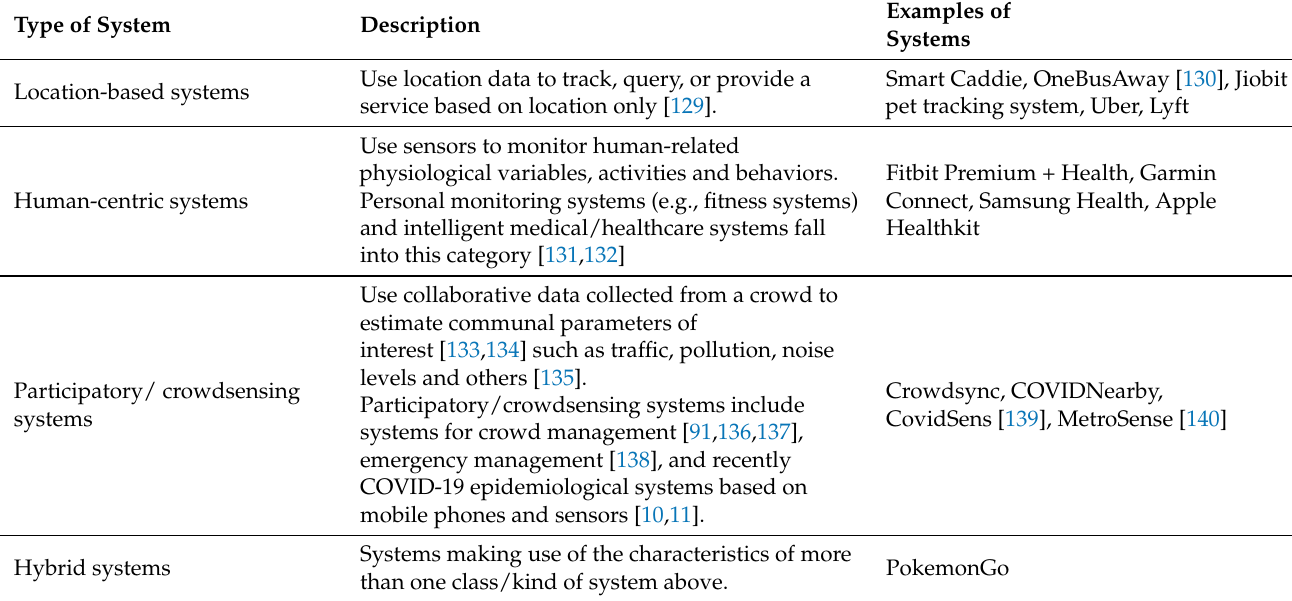
Table 4. Types of wearable sensing